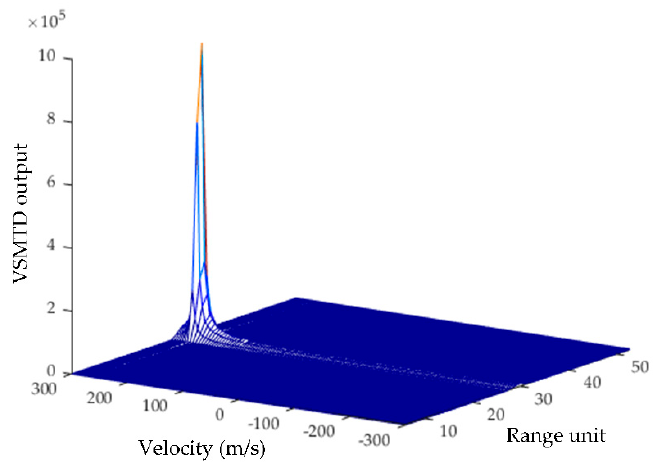
Figure 16. VSMTD results with V T = 270 .